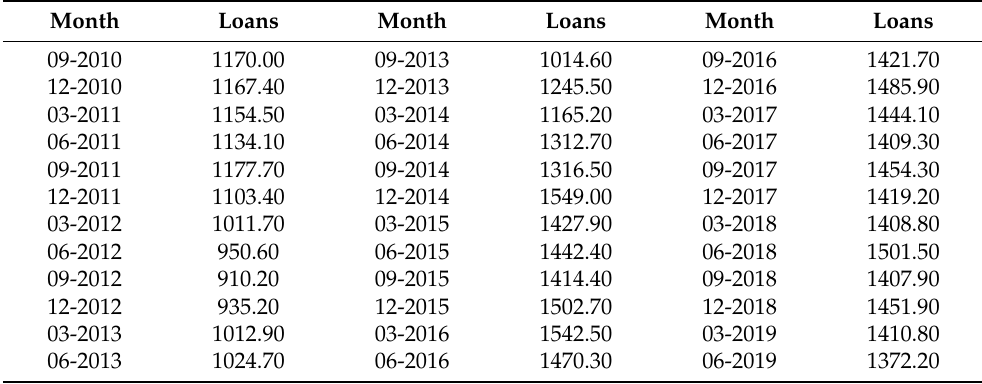
Own processing of data from the Bank of